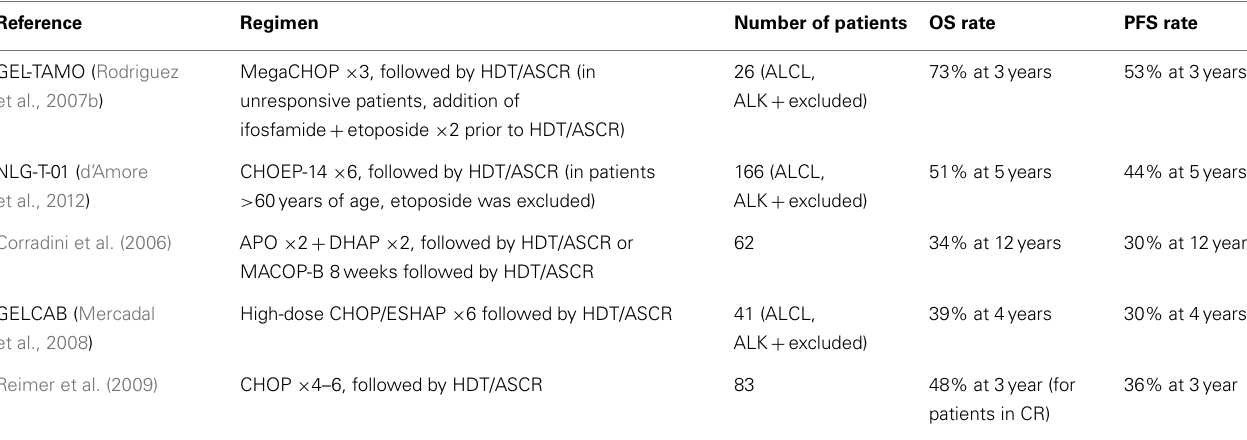
Table 1 | Clinical trials of HDT/ASCR for